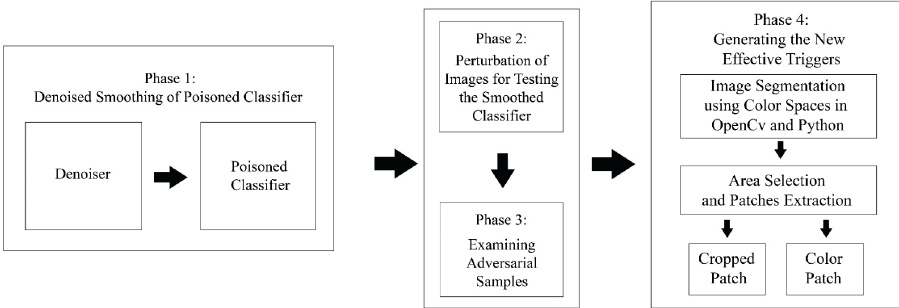
Figure 1. A visual representation of our automatic attack model. Given a poisoned classification model, denoised smoothing generates a robust smoothed classifier. Then, the model extracts colors or different cropped blotches from adversarial instances of the smoothed classifier to create new triggers through image segmentation.